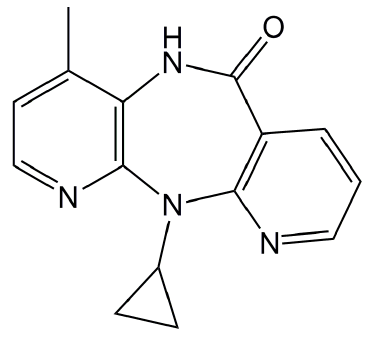
Figure 1. Chemical structure of nevirapine.